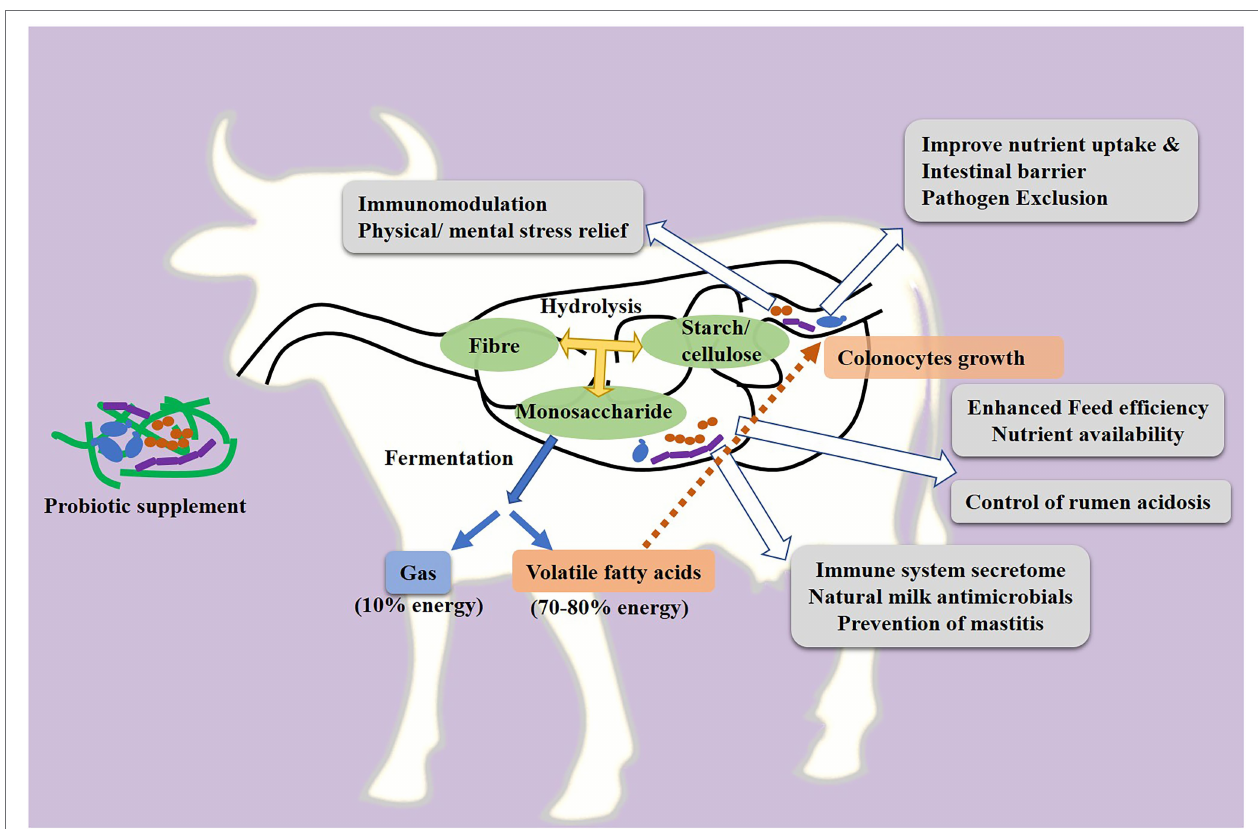
FIGURE 2 | Probiotic activity to enhance the growth and general health of dairy animals. Yellow arrows in the figure indicate enzymatic digestion of feed in the gut; blue arrows indicate microbial fermentation of feed-derived monosaccharides; white arrows indicate the different beneficial mechanisms of probiotics, and the dotted red arrow indicates the VFA-mediated growth promotion of